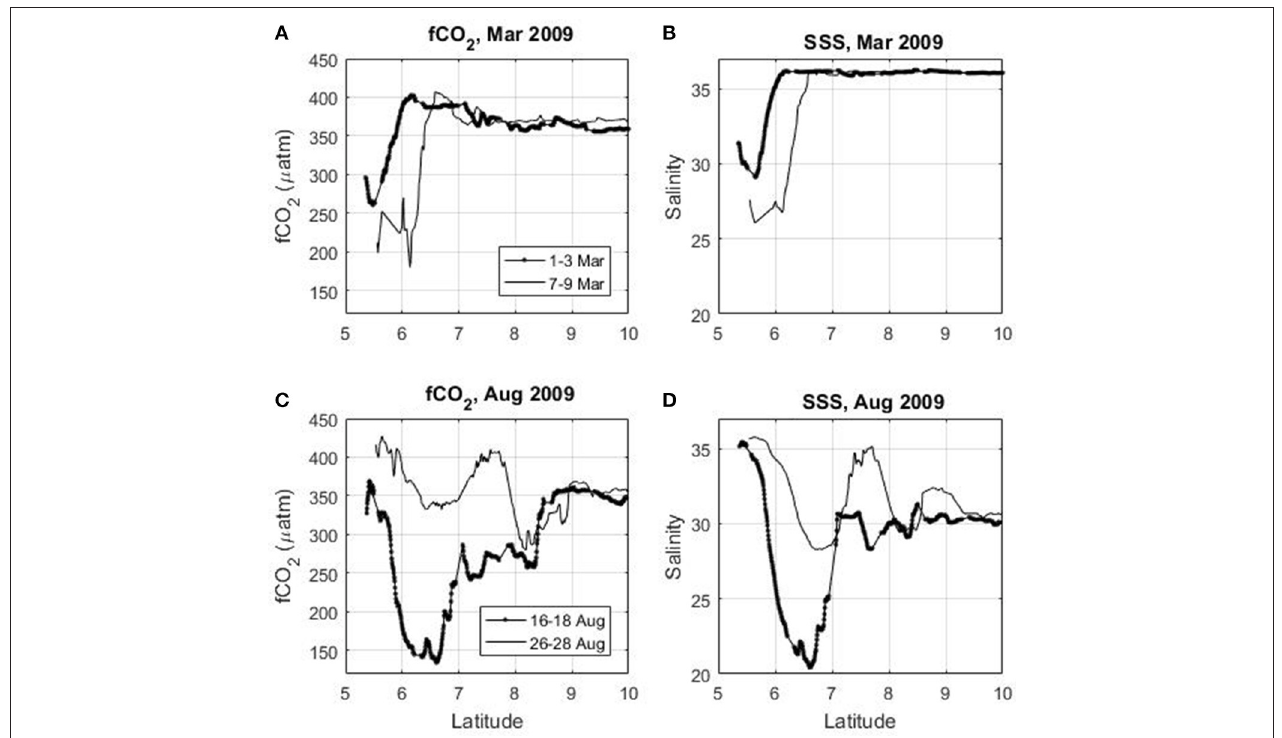
FIGURE 9 | Latitudinal distribution of (A) surface fCO 2 , (B) salinity in March 2009, (C) fCO 2 , and (D) salinity in August 2009 using the Colibri cruises.